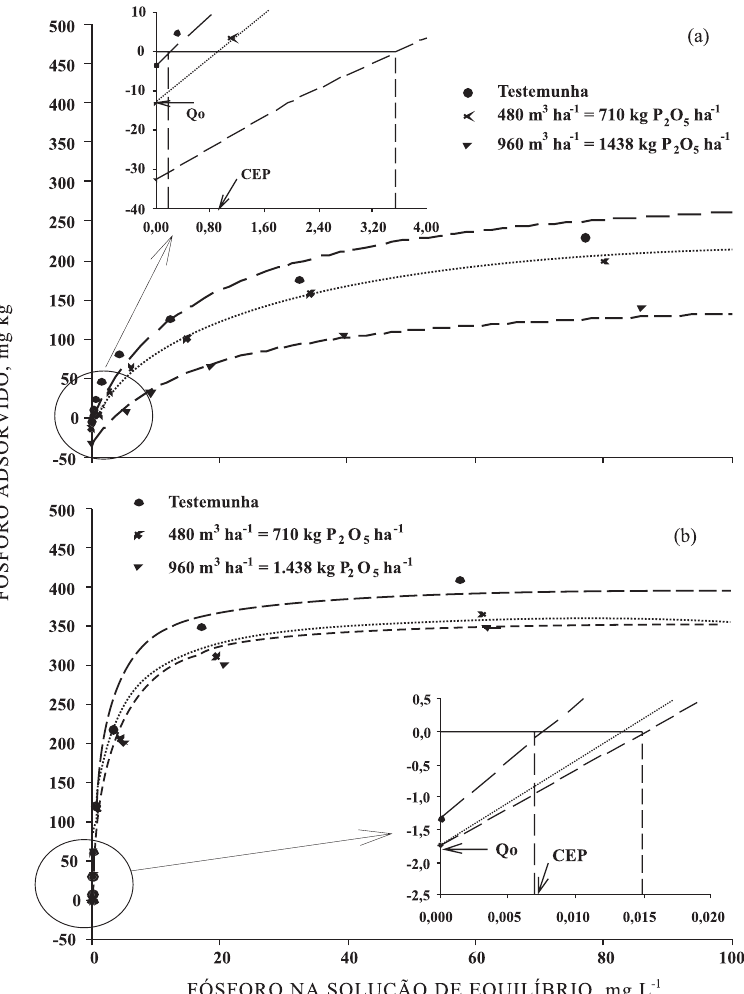
Figura 2. Relação entre o fósforo adsorvido e o fósforo na solução de equilíbrio do solo das camadas de 0– 2,5 cm (a) e 30–60 cm (b) com aplicação de dejeto líquido de suínos na superfície de um Argissolo manejado sob sistema plantio